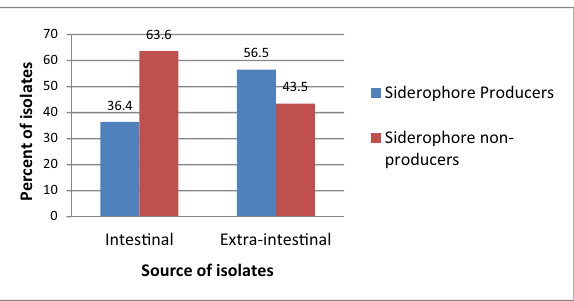
Figure 1: Percentage of siderophore producers ( % ) among patho - genic intestinal and extraintestinal E. coli isolates.